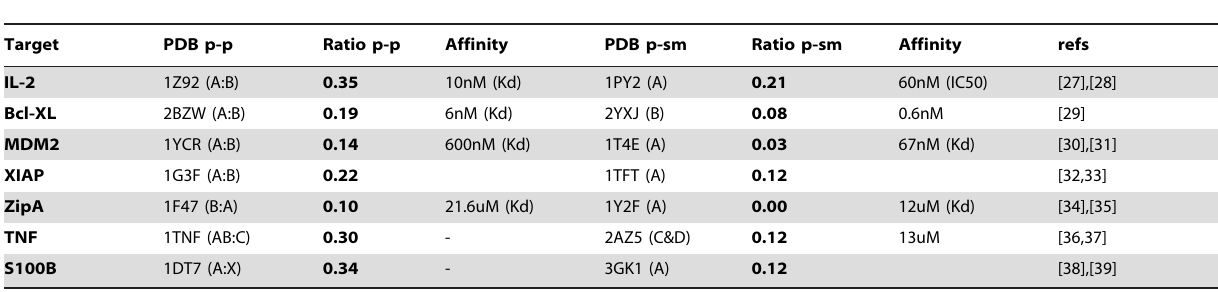
Table 1. Examples of polar ratio in protein